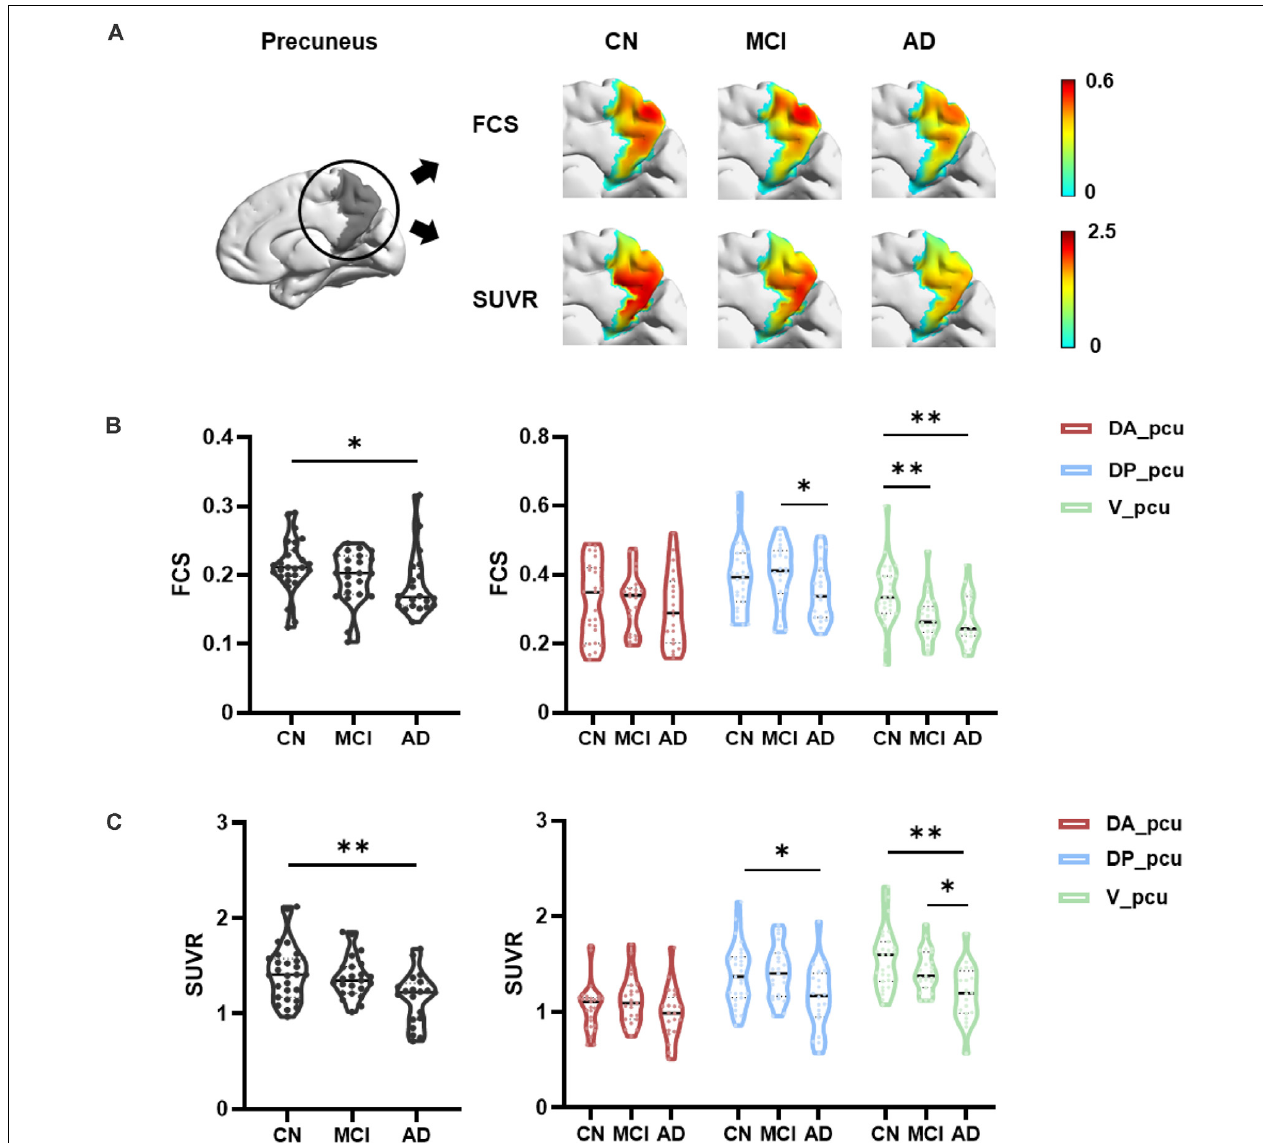
FIGURE 2 | Differences in the FCS and SUVR in the whole precuneus and its subregions between the CN, MCI, and AD groups. (A) Maps of both FCS ad SUVR within the precuneus decreased in patients. (B) For the whole precuneus, decreased FCS was observed in the AD patients compared to the CN group. For the subregions of the precuneus, decreased FCS was found in DP_pcu in AD patients compared to the MCI group, and in V_pcu in patients with AD and MCI compared to the CN group. No difference was observed in the FCS of DA_pcu among the three groups. (C) For the whole precuneus, decreased SUVR was observed in AD patients compared to the CN groups. For the subregions of the precuneus, decreased SUVR was found in DP_pcu of AD patients compared to the CN group, and in V_pcu of AD patients compared to both the MCI and CN groups. No difference in the SUVR of DA_pcu was observed among the three groups. Between-group differences were compared via ANCOVA with post hoc least significant difference tests and Bonferroni corrections. Age, gender, and education were considered as covariates. ∗ p < 0.05, uncorrected; ∗∗ p < 0.05, Bonferroni corrected. Abbreviations: FSC, functional connectivity strength; SUVR, standard uptake value ratio; CN, cognitively normal; MCI, mild cognitive impairment; AD, Alzheimer’s Disease; V_pcu, ventral precuneus; DP_pcu, dorsal posterior precuneus; DA_pcu, dorsal anterior precuneus; ANCOVA, analysis of covariance.